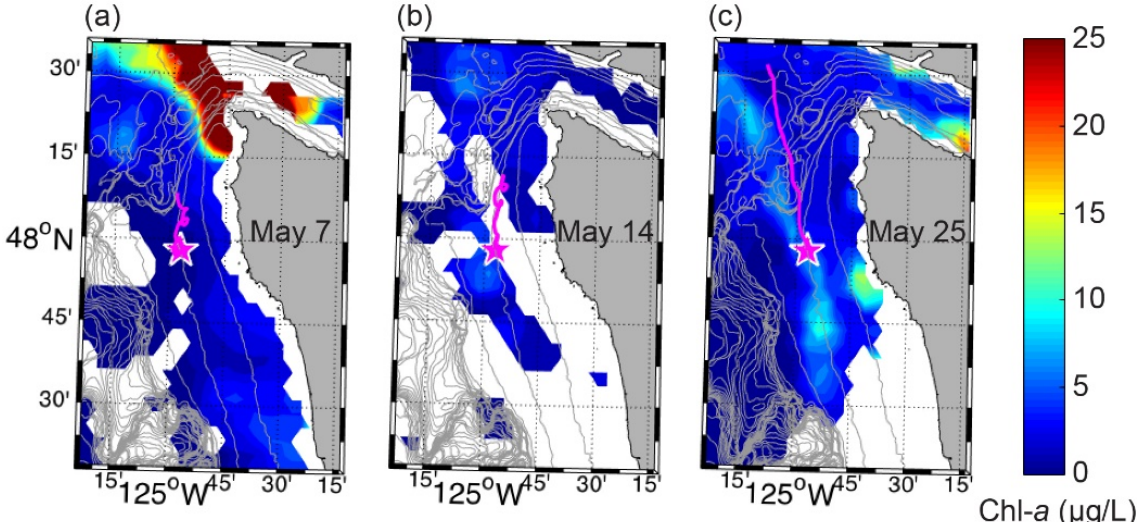
Figure 8. VIIRS daily, near-surface chlorophyll- a concentrations with 50-m bathymetry contours overplotted for ( a ) 7 May, ( b ) 14 May, and ( c ) 25 May of 2017. Local time (Pacific Daylight Time) is approximately 13:45 for each day. Gaps in coverage are largely due to cloud cover and fog. The magenta star shows the location of the ESP mooring. The magenta line shows 2-day duration progressive vector tracks calculated by backwards-integrating NEMO-SS ADCP measurements in time, suggesting a potential past trajectory of water arriving at the mooring site.